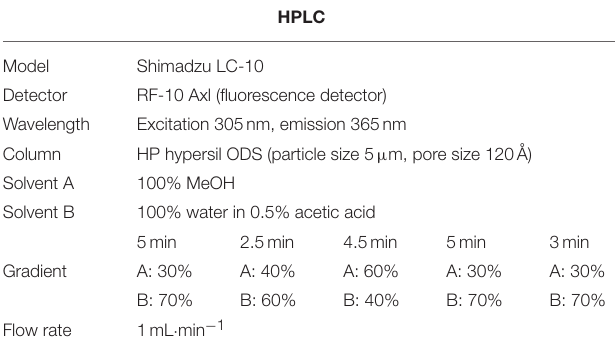
TABLE 3 | HPLC operation conditions for the analysis of salicylic